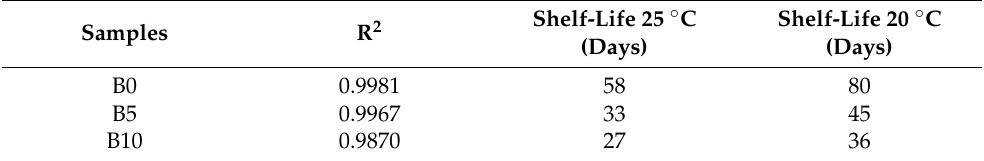
Table 2. Estimation of shelf-life of control and fortified breadsticks at 20 and 25 ◦ C. The coefficient of determination (R 2 ) of linear regression performed by OXISoft™ program is also reported.